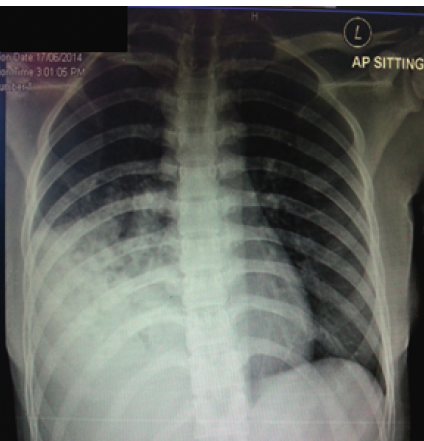
Figure 1: Chest radiography showed right lower lobe consolidation.